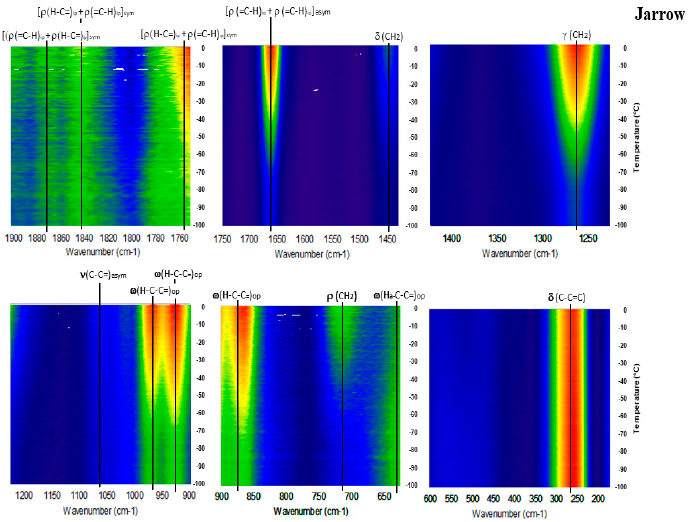
Figure 9. GTRS contour plot, fish oil concentrated in DHA by molecular distillation (JW).